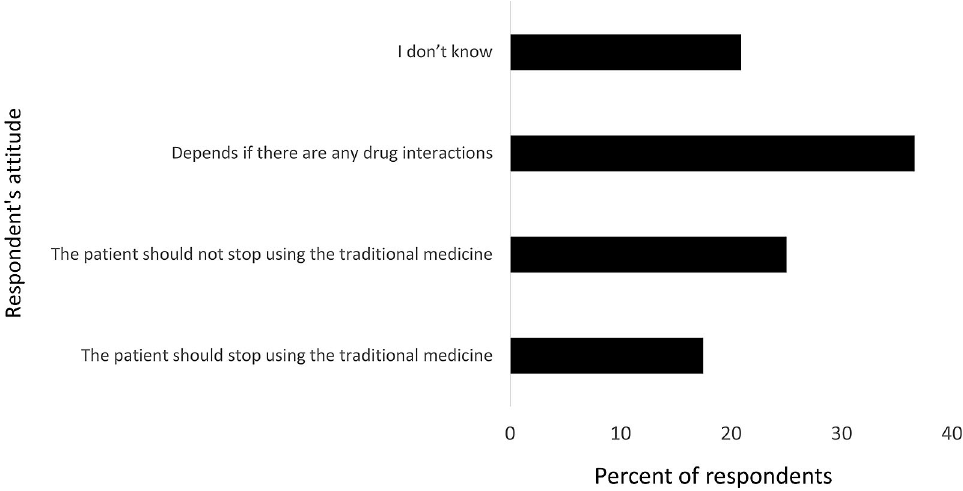
Figure3.Pharmacypractitioners ’ attitudestowardstoppingtheuseofconventionaldrugswhileusingherbal